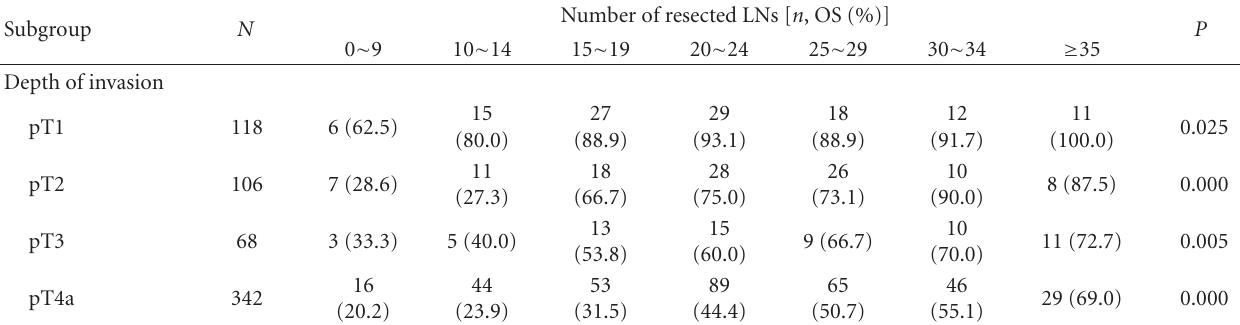
Table 4: Five-year overall survival by stage subgroups and total number of resected LNs.